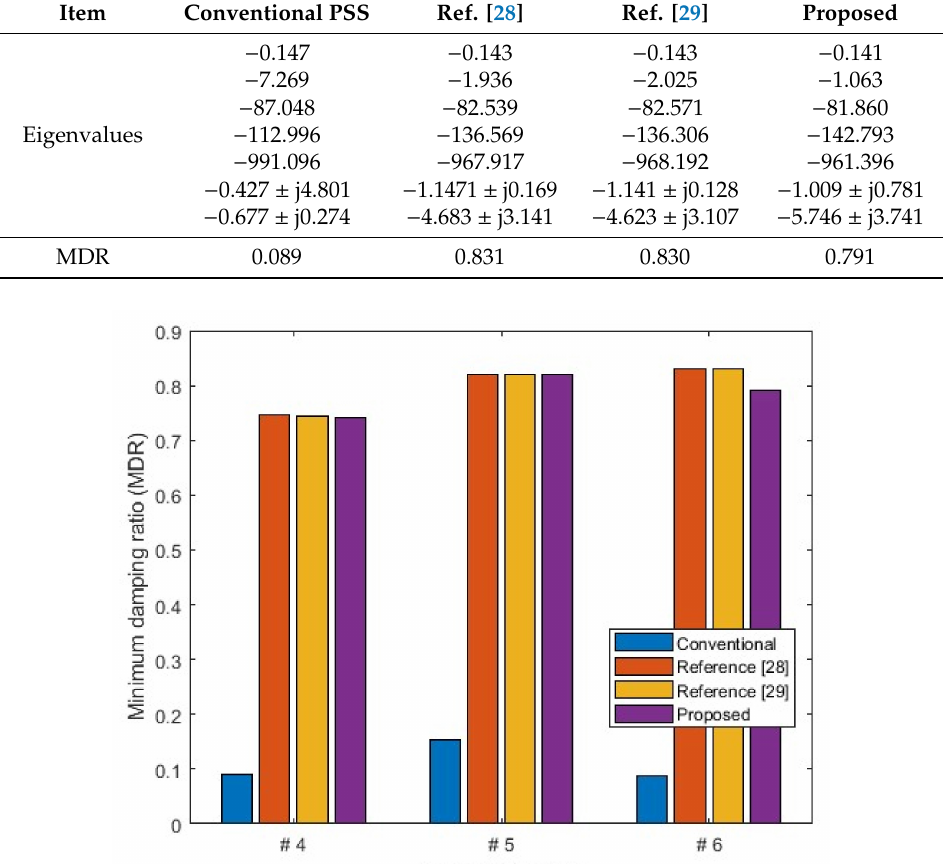
Figure 14. MDR comparison for three selected operating situations (second